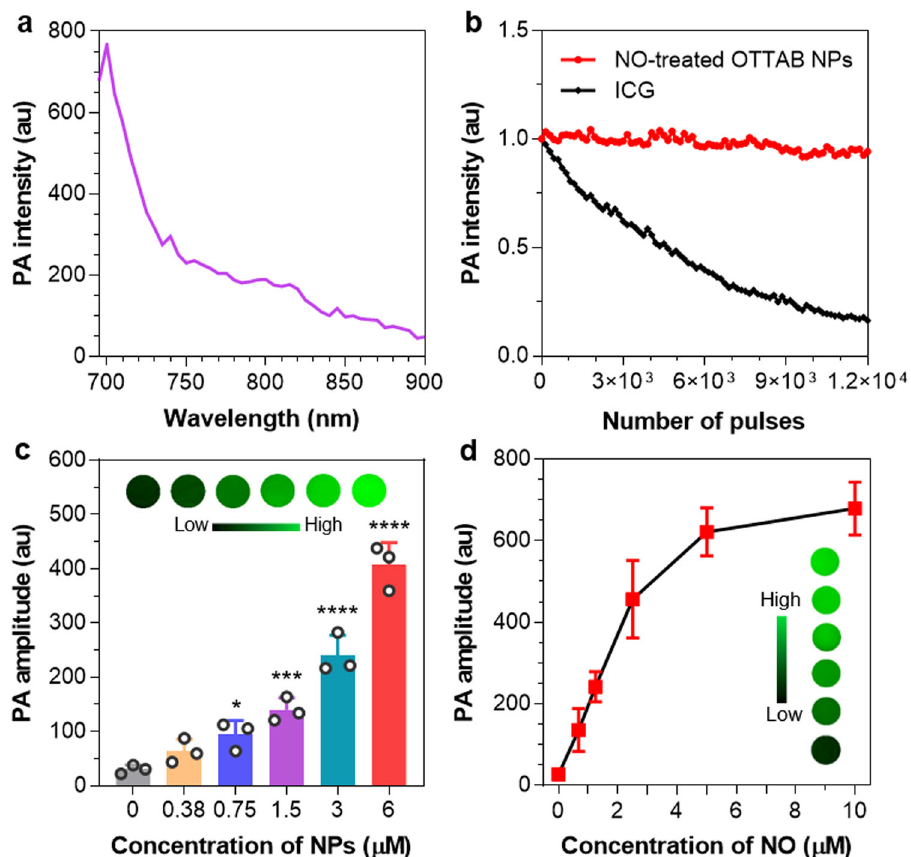
Fig. 5 In vitro detection of NO. a PA spectrum of the NO-treated OTTAB NPs (10 µ M). b Plots of the PA intensity of NO-treated OTTAB NPs ( λ ex = 690 nm) and indocyanine green (ICG, λ ex = 790 nm) in a phantom (10 µ M) against number of laser pulses (17.5 mJ cm − 2 laser and 10 Hz pulse repetition rate). c PA amplitudes and the corresponding representative PA images of the NO-treated OTTAB NPs as a function of concentration. Data are presented as mean ± s.d. ( n = 3 independent experiments). * p = 0.017, *** p = 0.00049, **** p < 0.0001 (3 vs. 0: p = 1 × 10 − 6 , 6 vs. 0: p = 1.5 × 10 − 9 ) compared to 0 µ M of NPs using one-way ANOVA for multiple comparisons. d PA amplitudes and the corresponding representative PA images of OTTAB NPs (10 µ M) after the treatment with different concentrations of NO. Data are presented as mean ± s.d. ( n = 3 independent